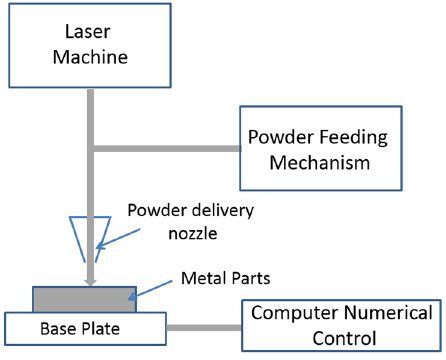
Figure 3. Schematic diagram of rapid prototyping technique.